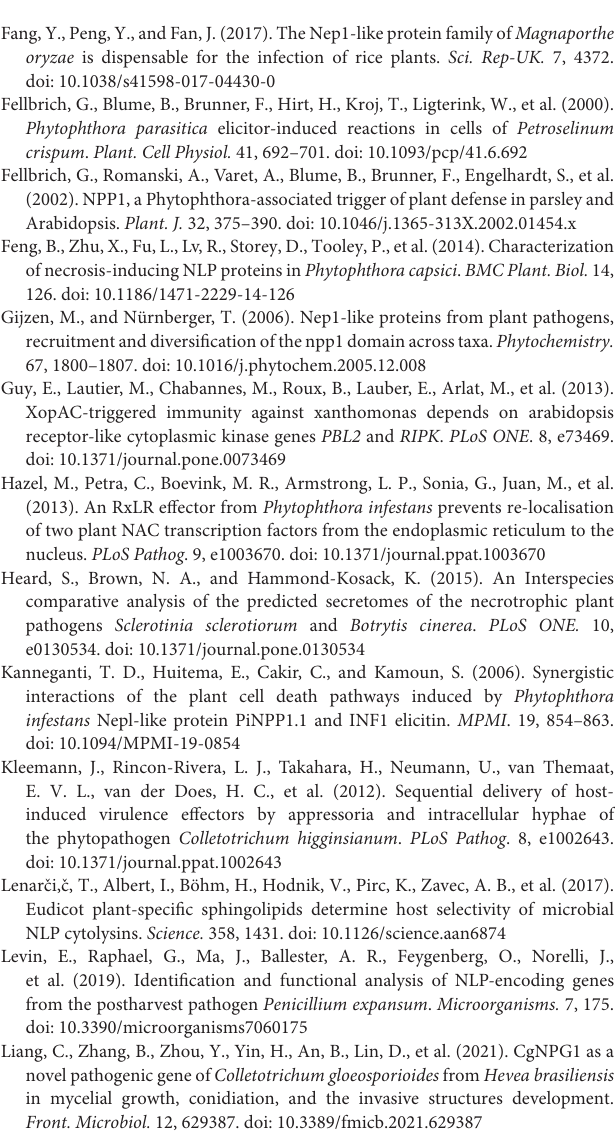
Supplementary Figure S1 | Nucleotide sequence and deduced amino acid sequence of CgNLP1 . Shading indicates the amino acid sequences of the signal peptide. Supplementary Figure S2 | Generation and molecular confirmation of CgNLP1 deletion mutant ( 1 CgNLP1 ) and complementation mutant (Res- 1 Cg NLP1 ). (A) The diagram of the CgNLP1 knockout vector. (B) Diagnostic PCR analysis for deletion of CgNLP1 and integration of CgNLP1 into the genome of C. gloeosporioides . (C) The expression level of CgNLP1 in wild type (WT), 1 CgNLP1, and Res- 1 CgNLP1 by quantitative RT-PCR. Supplementary Figure S3 | Trypan blue transient of tobacco leaves expressing CgNLP1 . pEGAD indicates the tissue expressing empty vector pEGAD-eGFP, and